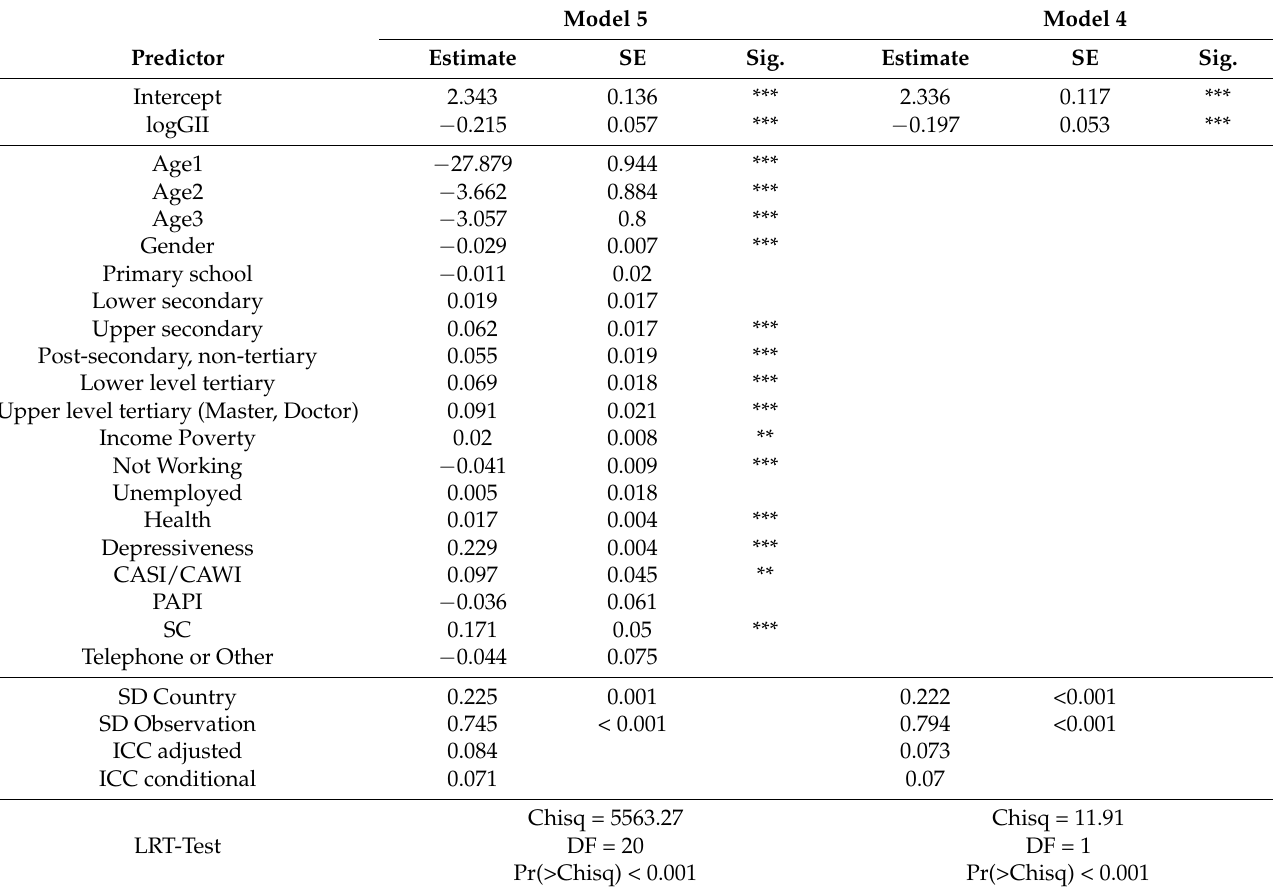
Table A3. Multilevel linear regressions of the effect of GII on SNI stress (Full Table